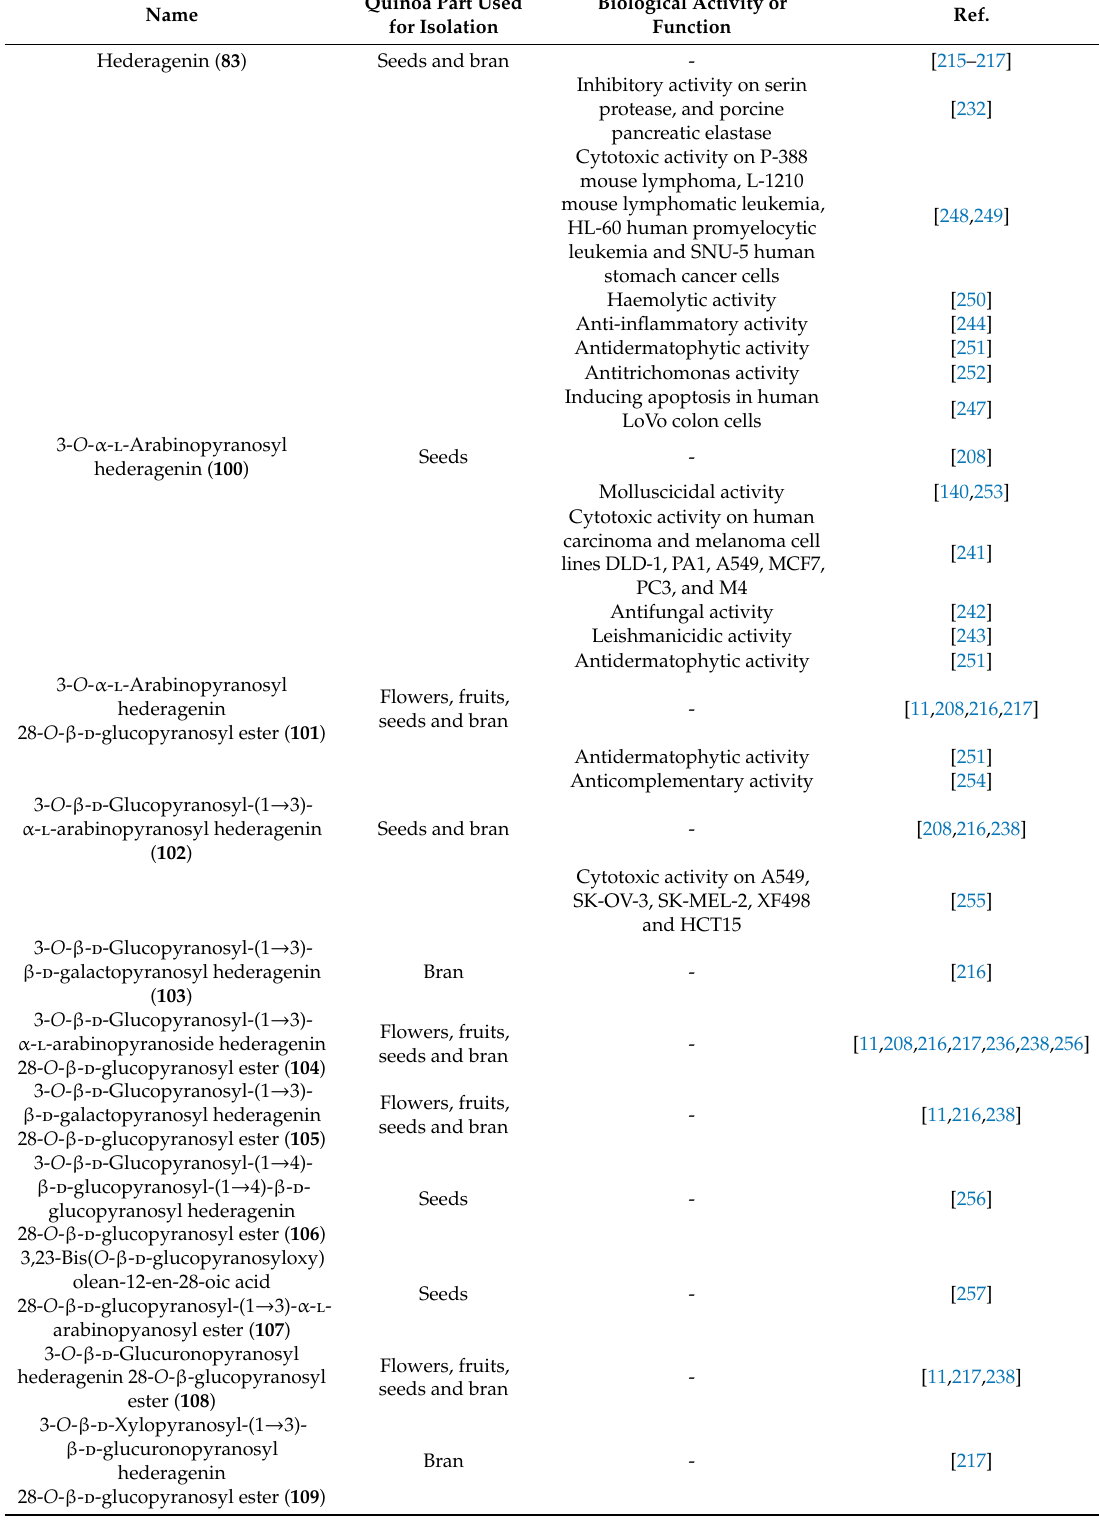
Table 10. Hederagenin derivatives and their biological activities or